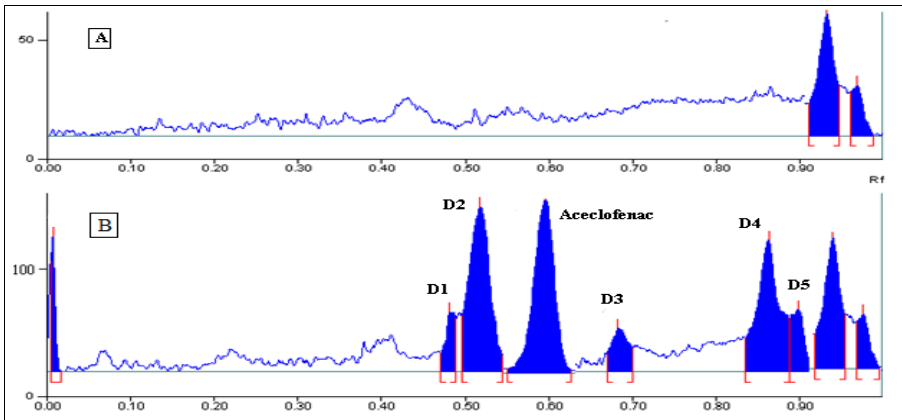
Figure 2. A- Blank NaOH, B- Mixture (500 ng/band) treated with NaOH.